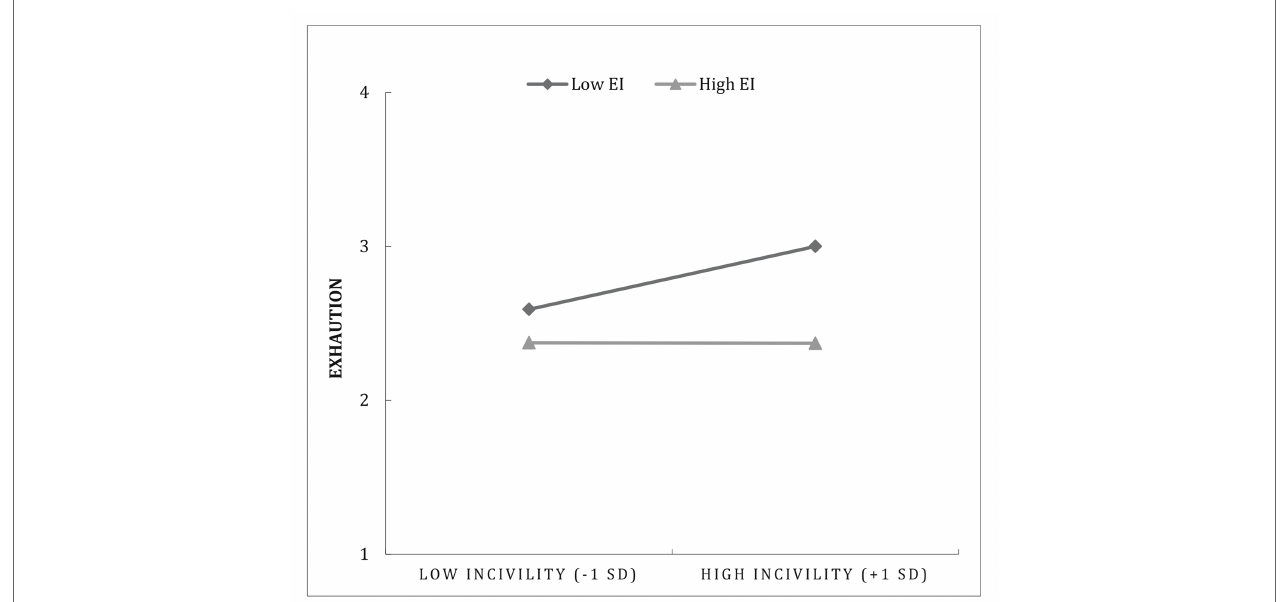
FIGURE 2 | Employee’s exhaustion as a function of the interaction between customer incivility and emotional intelligence.